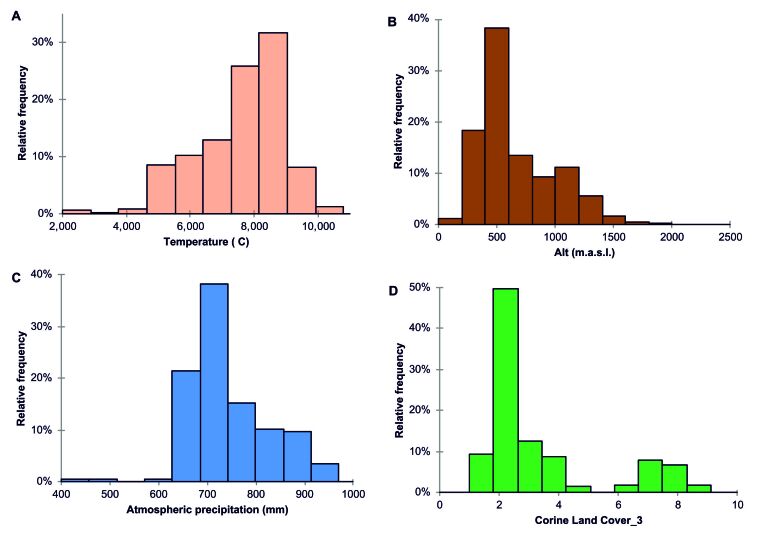
Figure 4. Relative frequency of troglobionts and stygobionts depending on the environmental characteristics of the surface. A. Temperature; B. Altitude; C. Precipitation; D. Vegetation: coniferous forest = 1, broad leaves forest = 2, mixed forest = 3, grassland = 4, woodland-shrubs = 5, bare rocks = 6, pastures = 7, agriculture land = 8, urban + mineral extraction = 9. Note that Movile Cave is not introduced in the analysis. Climatic data from Fick and Hijmans (2017), vegetation data from Academia RSR (1981)